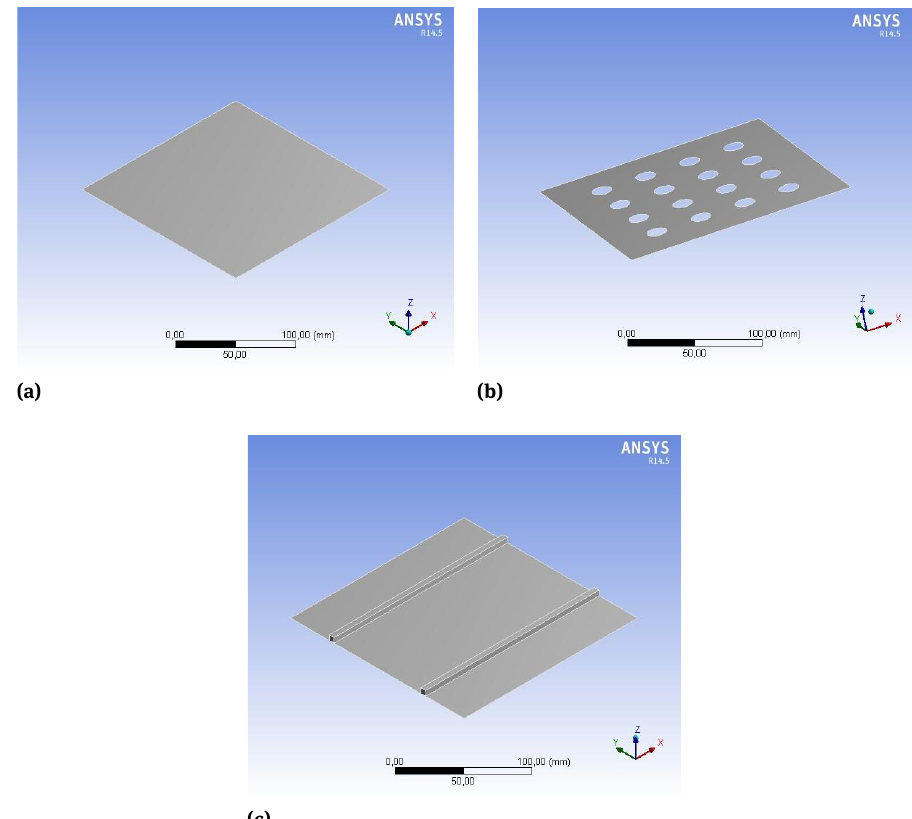
Figure 3: Design sketch model simulation of metal sheet: ( a ) virgin metal sheet; ( b ) hole metal sheet; ( c ) stiffener metal